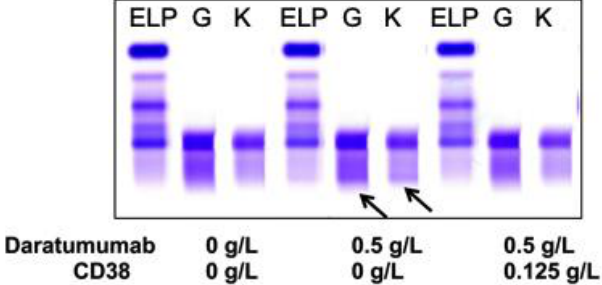
Figure 3. A representative of plasma cell myeloma (PCM) patient sera with endogenous IgG (G) kappa (K) M-protein spiked with DARA resulted in a clear IgG kappa M-protein (indicated by arrows) on sIFE gel. Incubation of DARA spiked PCM serum with 0.125 g/L of biotinylated recombinant CD38 and magnetic beads successfully extracted the DARA with a magnetic stand and completely eliminated the IgG kappa component on sIFE gel with all tested concentrations of recombinant CD38. CD38/DARA complex does not affect the endogenous M-protein migration. The impact of the recombinant biotinylated CD38-DARA complex on the endogenous M-protein quantification in six patients with a range of endogenous M-protein concentration (0.3–2.9 g/dL) was also assessed. The Bland–Altman difference versus the average indicated a −0.0033 g/dL bias in